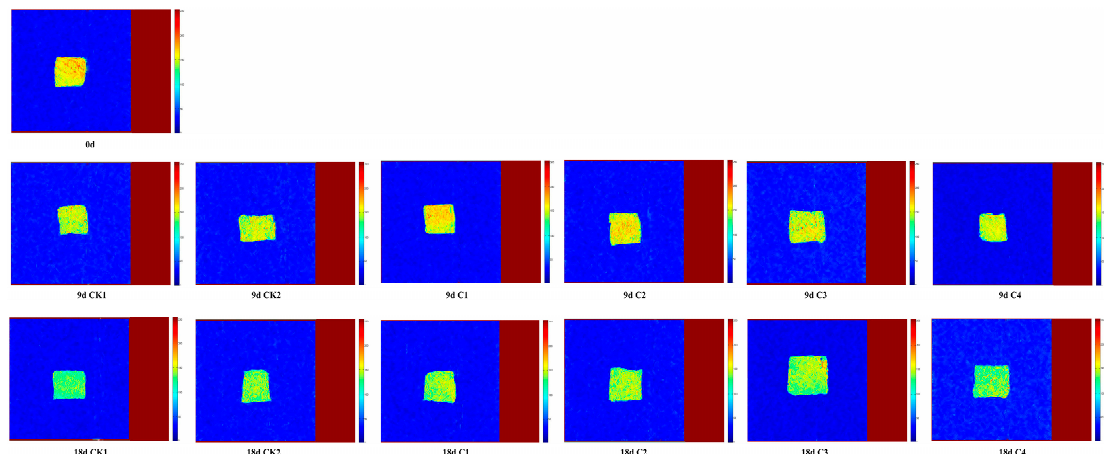
Figure 4. Changes in magnetic resonance imaging (MRI) of half-smooth tongue sole fillets during refrigerated storage (CK1: Chitosan coating without rosmarinic acid or ε -PL; CK2: Chitosan coating with 30 mg / kg rosmarinic acid; C1 / C2 / C3 / C4: Chitosan coating with 30 mg / kg rosmarinic acid and 0.05% / 0.10% / 0.15% / 0.20% ε -PL). Table 4. Changes in water distribution of of di ff erent treated samples during refrigerated storage. Percentage of T 2